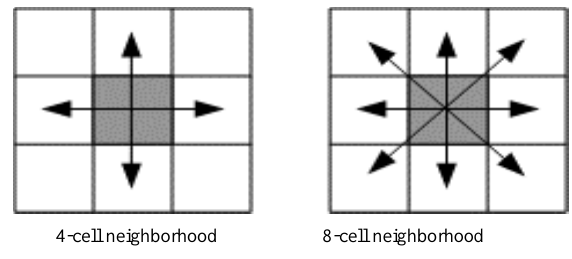
Figure 1. Types of neighborhoods .